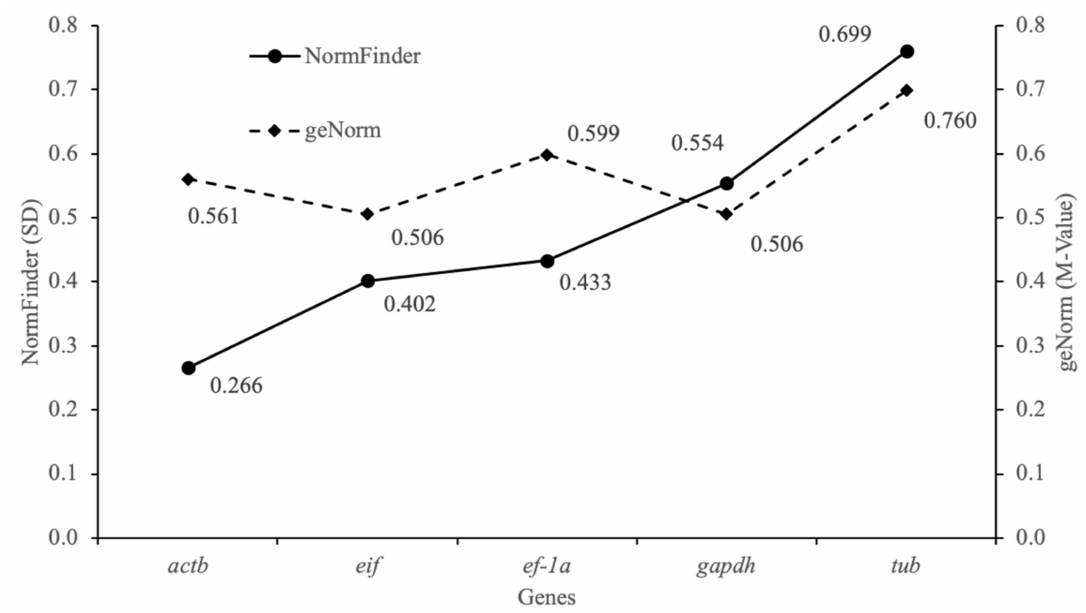
Figure 3. Ranking of gene stability values provided by geNorm and NormFinder. Five potential reference genes were tested for stability in the muscles of F. limosus females and males in spring and